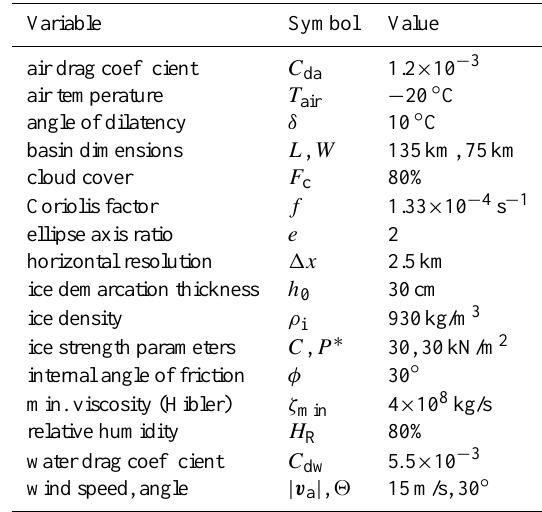
Table 1. Main physical parameters and constants used in the simu-